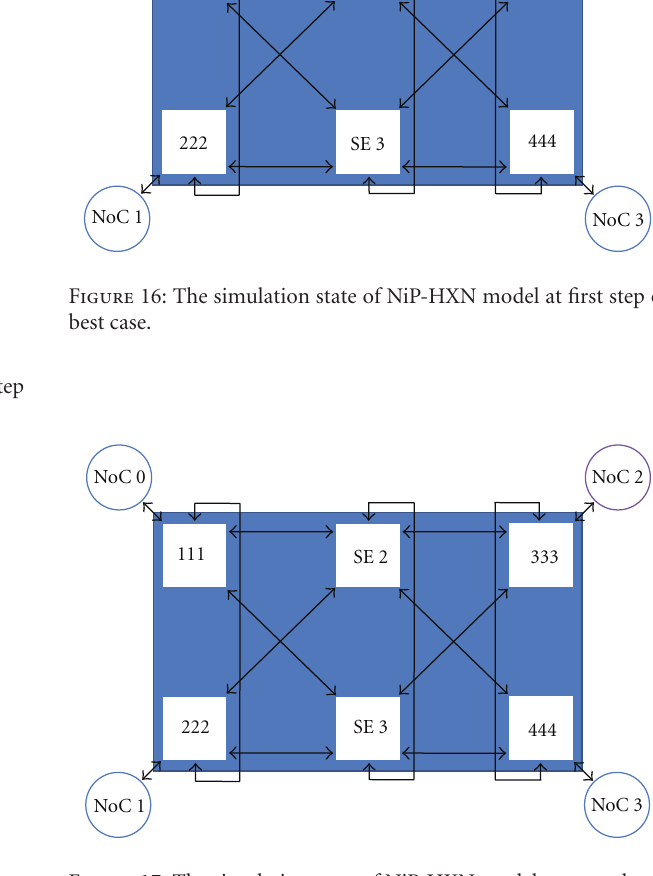
Figure 17: The simulation state of NiP-HXN model at second step of best case.